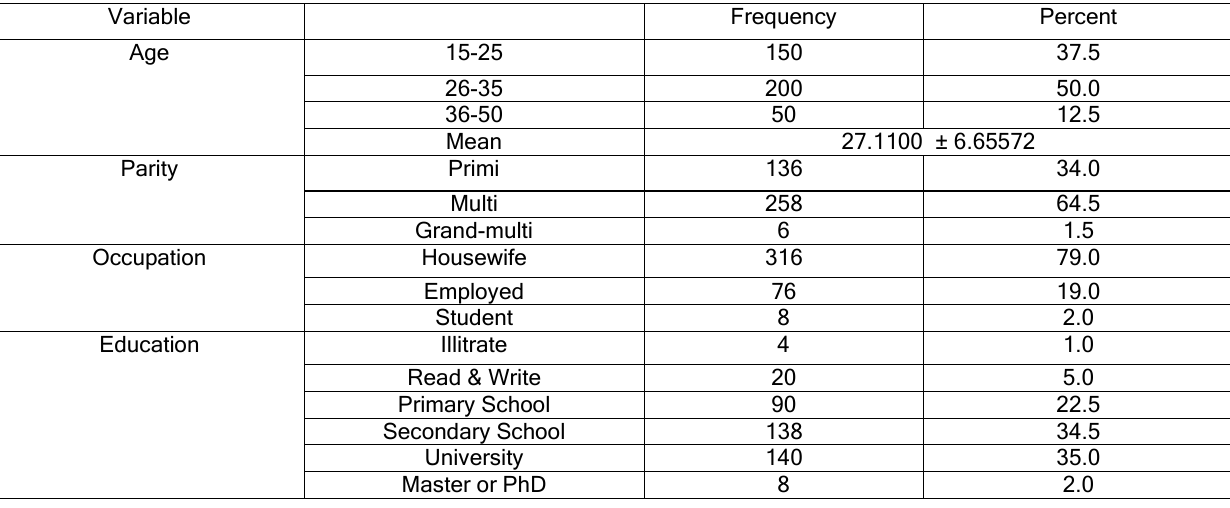
Table 1: Maternal Socio- Demographic Data